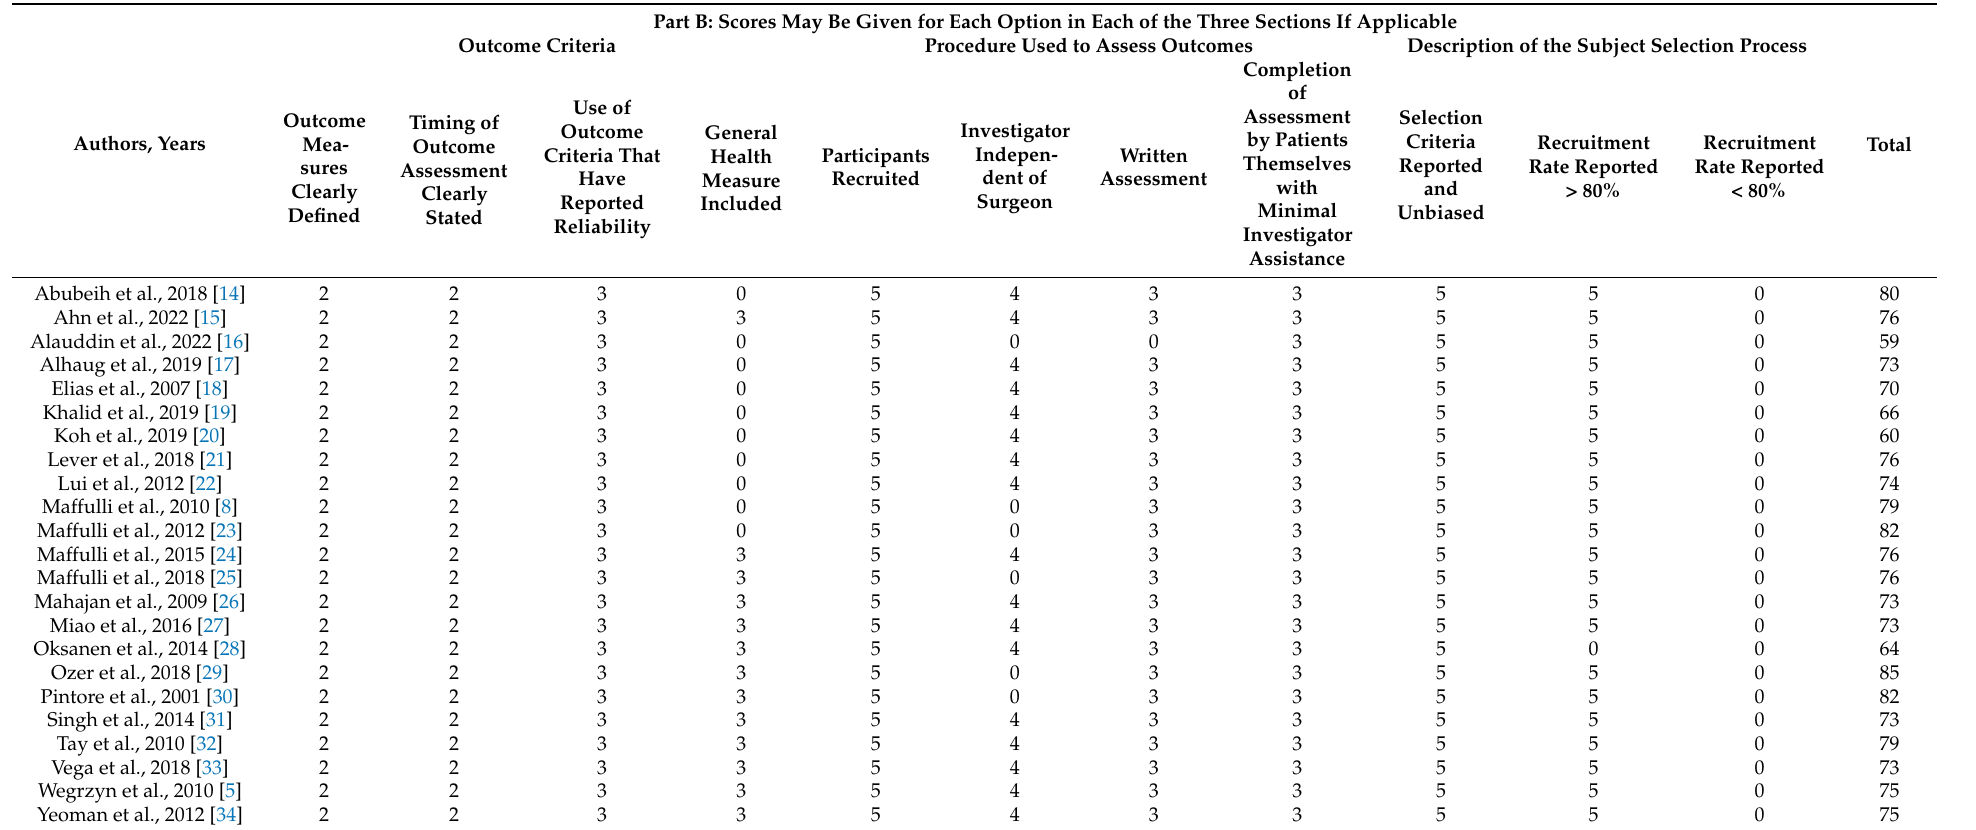
Table 2. Methodological Quality Assessment: Coleman Methodological